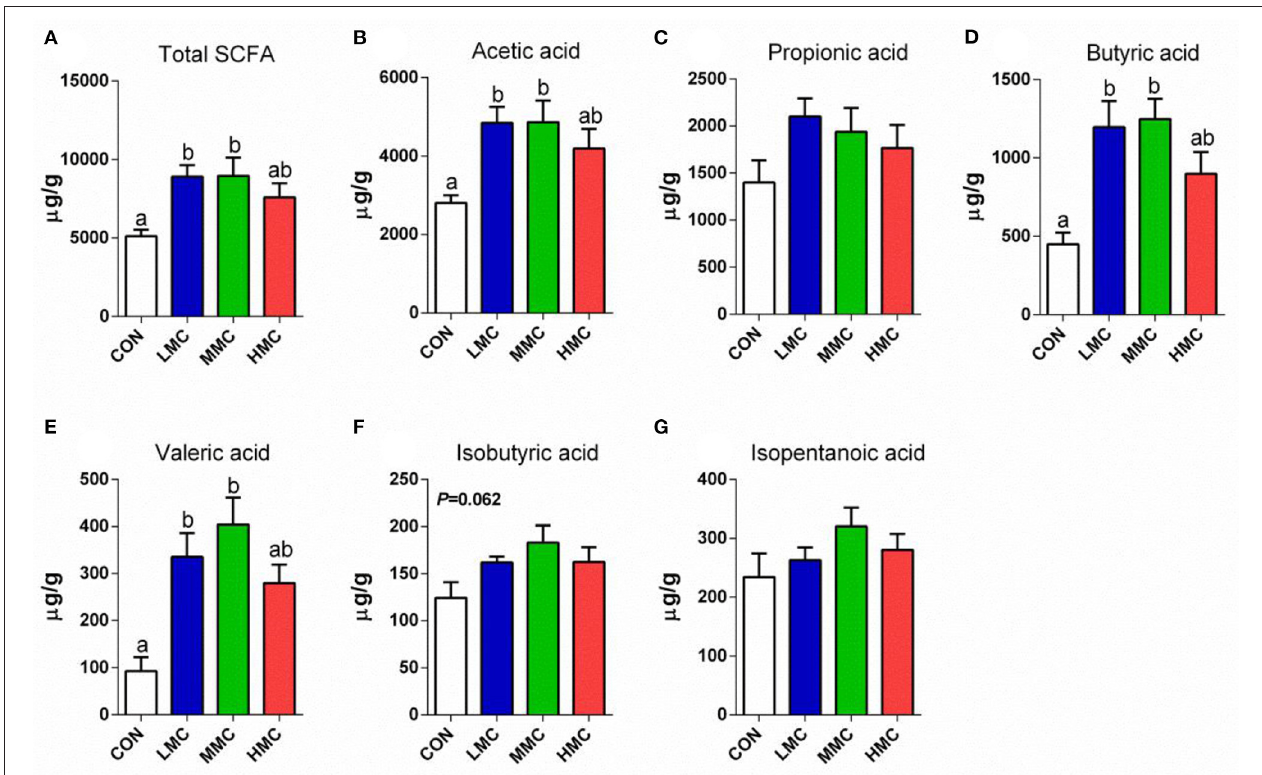
FIGURE 3 | Total SCFAs (A) , acetic acid (B) , propionic acid (C) , butyric acid (D) , valeric acid (E) , isobutyric acid (F) , and isopentanoic acid (G) concentrations in colonic contents of pigs fed the Moutan cortex radicis diet for 3 weeks. CON, control group, basal diet without antibiotics; LMC, the control diet + 2,000 mg/kg Moutan cortex radicis ; MMC, the control diet + 4,000 mg/kg Moutan cortex radicis ; HMC, the control diet + 8,000 mg/kg Moutan cortex radicis . Data are expressed as means ± SEM ( n = 8). Means with different superscripts in the columns are significantly different ( P <